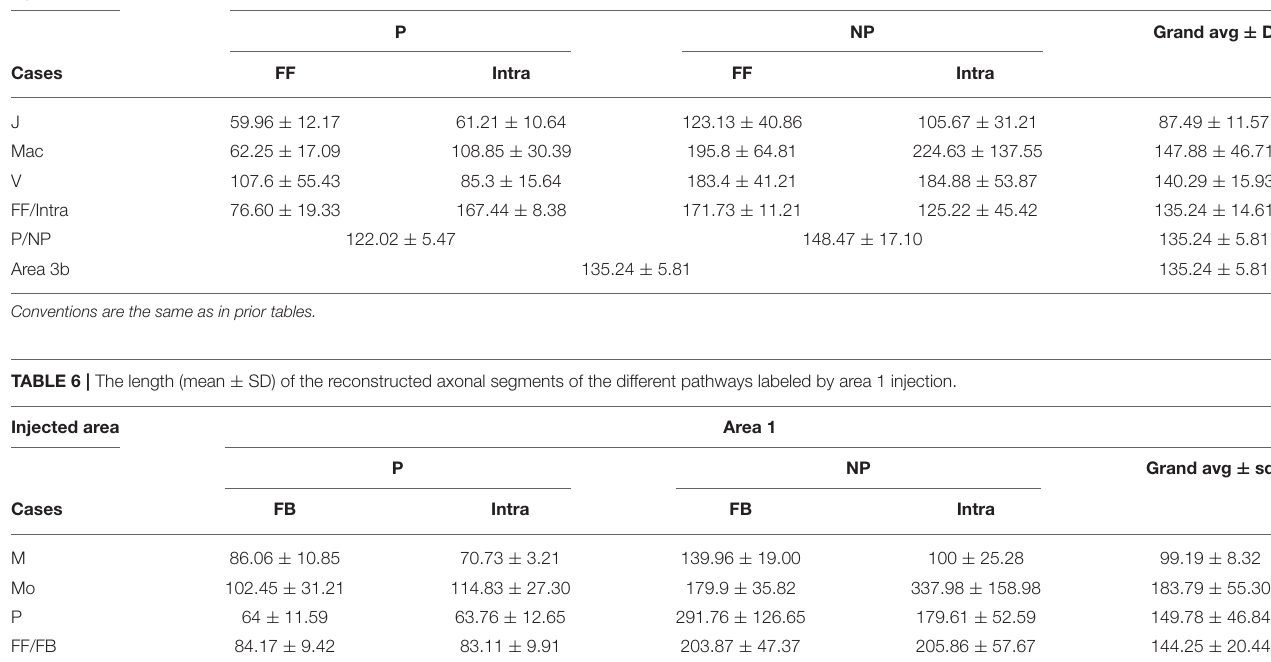
TABLE 5 | The length [mean ± standard deviation (SD)] of the reconstructed axonal segments of the different pathways labeled by area 3b injection. Injected area